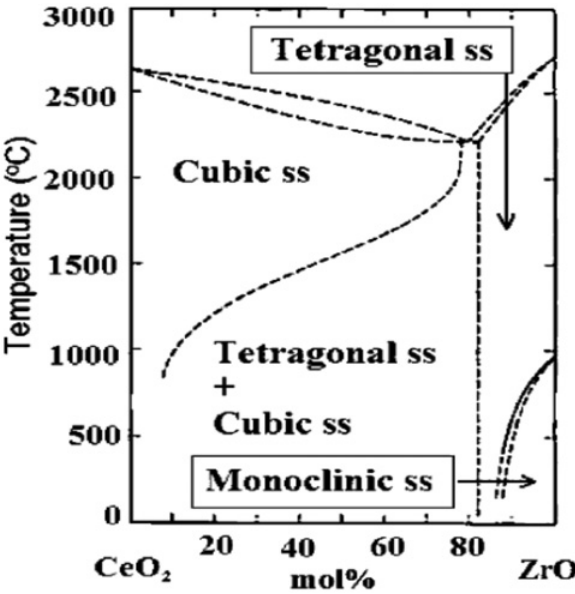
Figure 1: Phase diagram of CeO 2 -ZrO 2 reproduced from Saha and D.C Agarwal